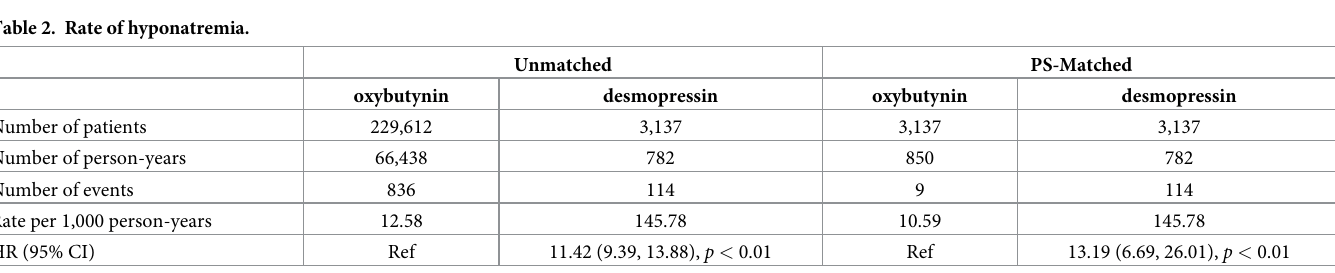
Table 2. Rate of